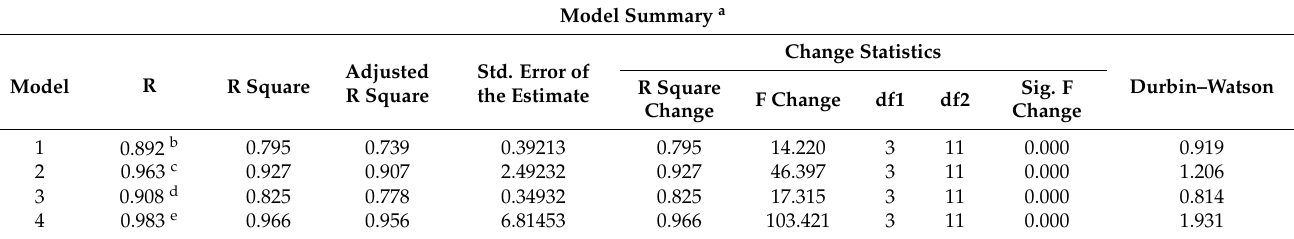
Table 8. Various Rs values for the selected